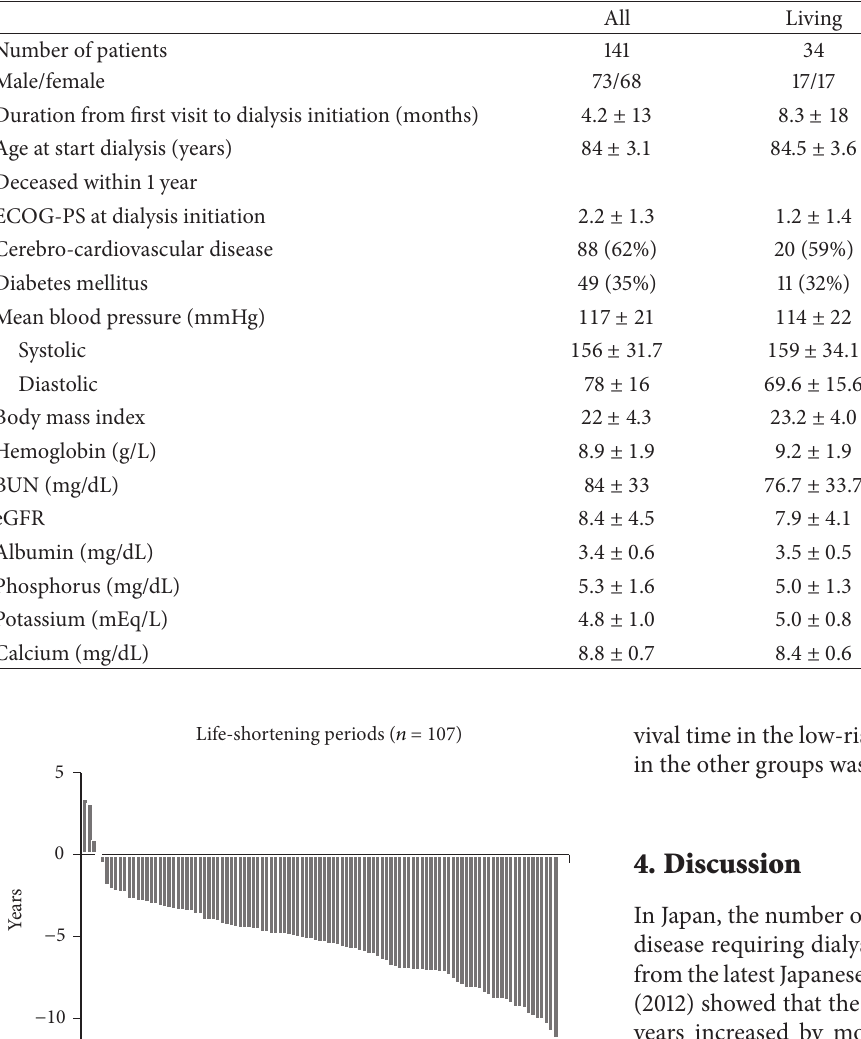
Table 2: Characteristics of dialysis patients aged ≥ 80 years.